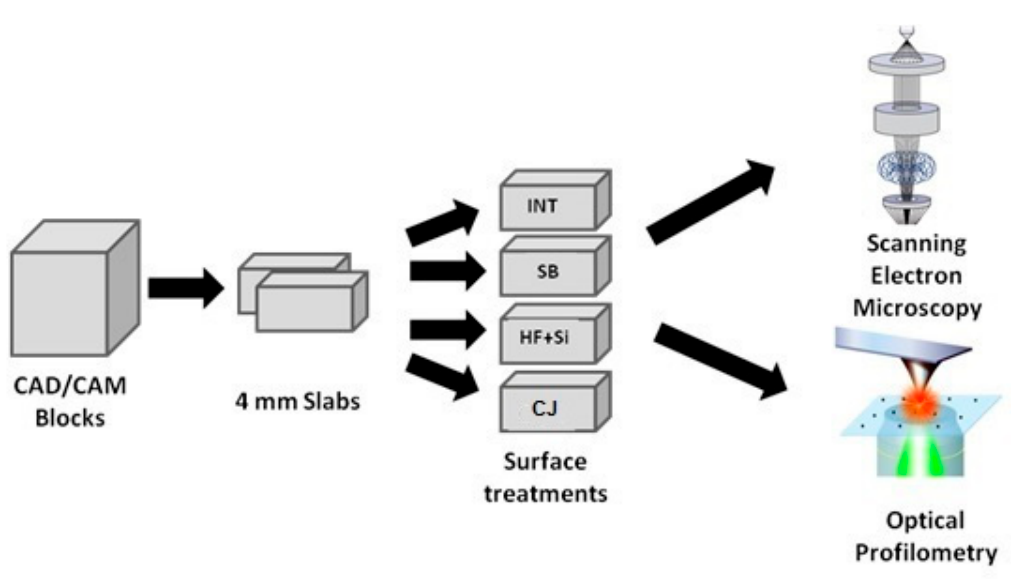
Figure 1. The schematic design of the study.